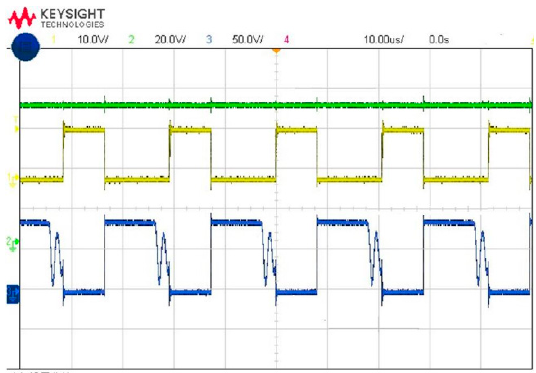
Figure 18. Photovoltaic circuit test waveform.